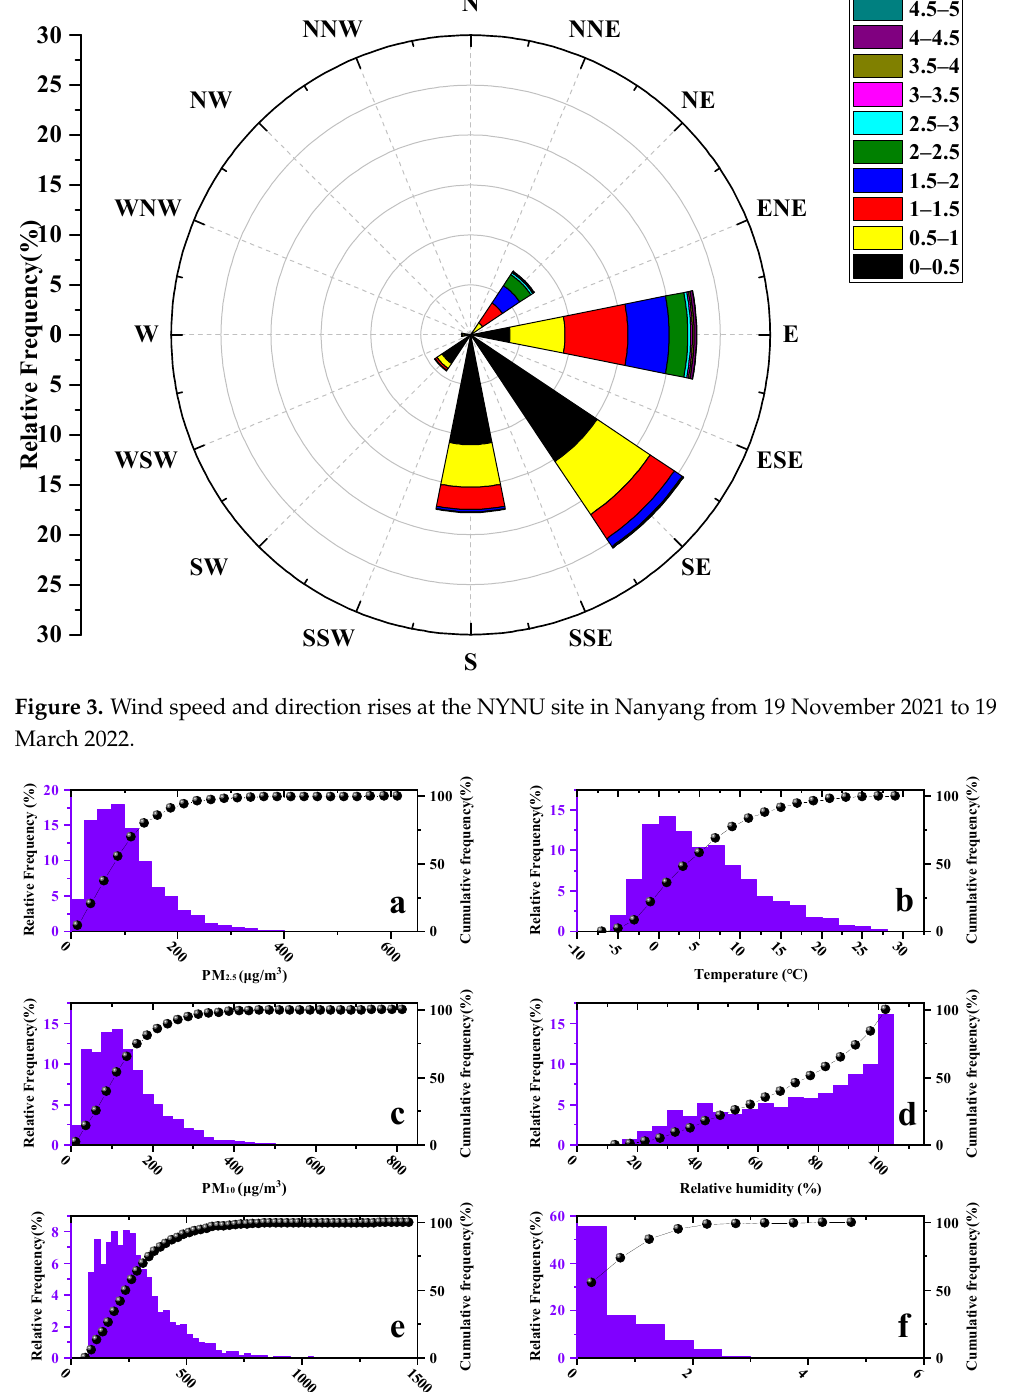
Figure 5. Daily trends of each variable at the NYNU station during the experimental cycle. Black dots represent the mean and red areas represent the standard deviation of ( a ) PM 2.5 (µg/m 3 ); ( b ) Temperature (°C); ( c ) PM 10 (µg/m 3 ); ( d ) Humidity (%); ( e ) Total suspended particulate ma tt er TSP (µg/m 3 ); ( f ) Windspeed (m/s). Table 3 presents PM 2.5 and PM 10 concentrations observed at several stations in China, including urban and rural stations. The mean and standard deviation of PM 2.5 and PM 10 in winter at the NYNU site were 106 ± 57µg/m 3 and 137 ± 74 µg/m 3 , respectively. As